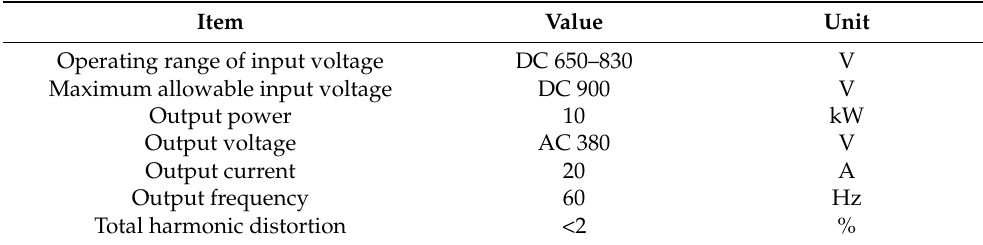
Table 2. Specifications of split dc-link capacitor 3-leg inverter for the experiment.